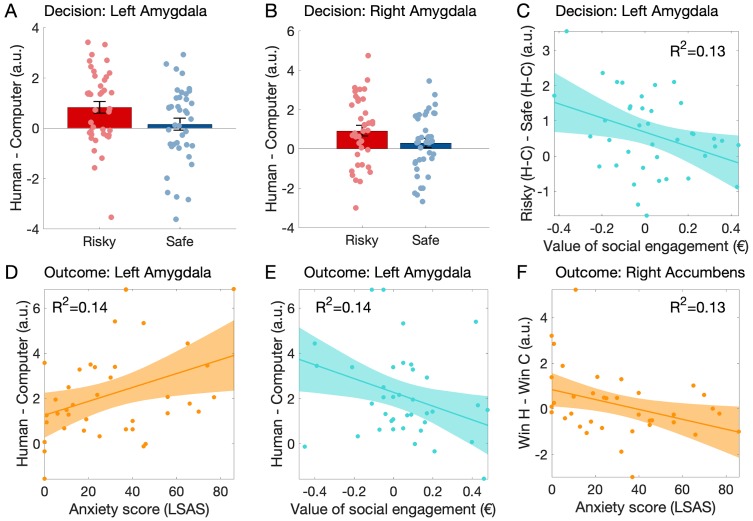
Variation of the neural activation as a function of choice, partner, social anxiety level (LSAS score) and the value of social engagement (CE50 human – CE50 computer) during the decision.(A–C) and the outcome (D–F) phases of the experiment. (A) During the decision phase of the trial (no face was shown), the left amygdala response was higher when participants chose the risky option against the human rather than the computer; this difference was not found when participants chose the safe option. (B) Similar effects were observed in the right amygdala. (C) In the left amygdala, the response difference between risky choices with human vs. computer partners and safe choices with human vs. computer partners (interaction: risky - safe choices X human - computer) decreased with the measured value of social engagement. (D) During the outcome stage of the game, the left amygdala response to outcomes of gambles against a human (=emotional expressions) compared to a computer increased with LSAS and (E) decreased with the measured value of social engagement. (F) In the right nucleus accumbens, the response difference between winning against a human partner rather than a computer partner decreased with LSAS. A.u.: arbitrary units. In panels A and B, central tendency is the mean and indicated by bar height, error bars indicate standard error of the mean. Grey-shaded areas represent the 95% confidence intervals around the slope of the regression line.